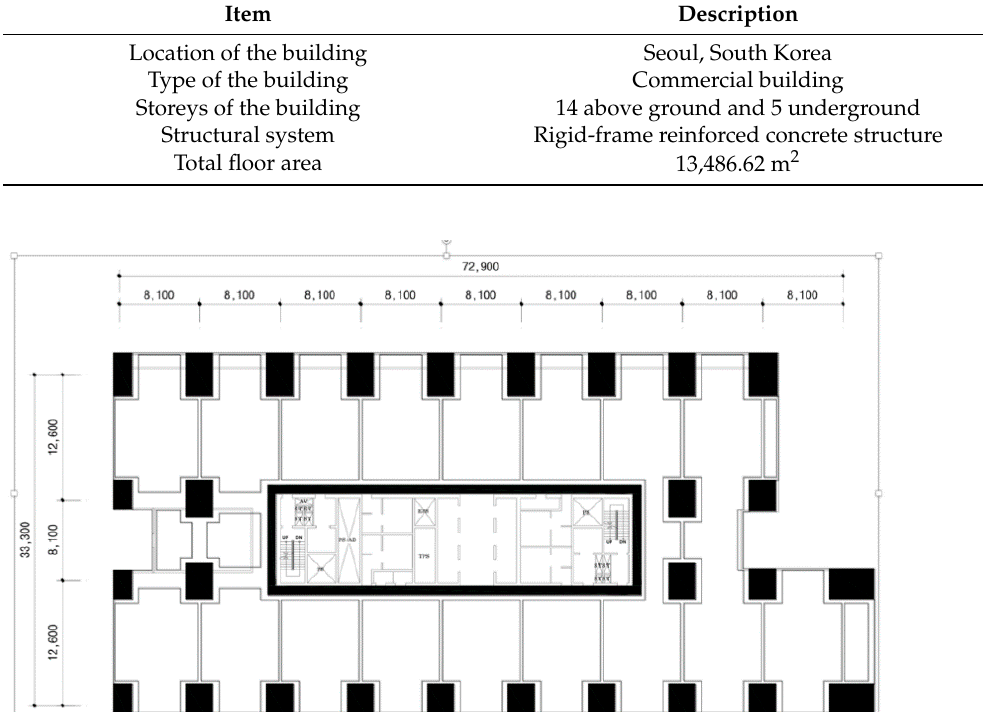
Figure 1. The floor plan of the case study building.